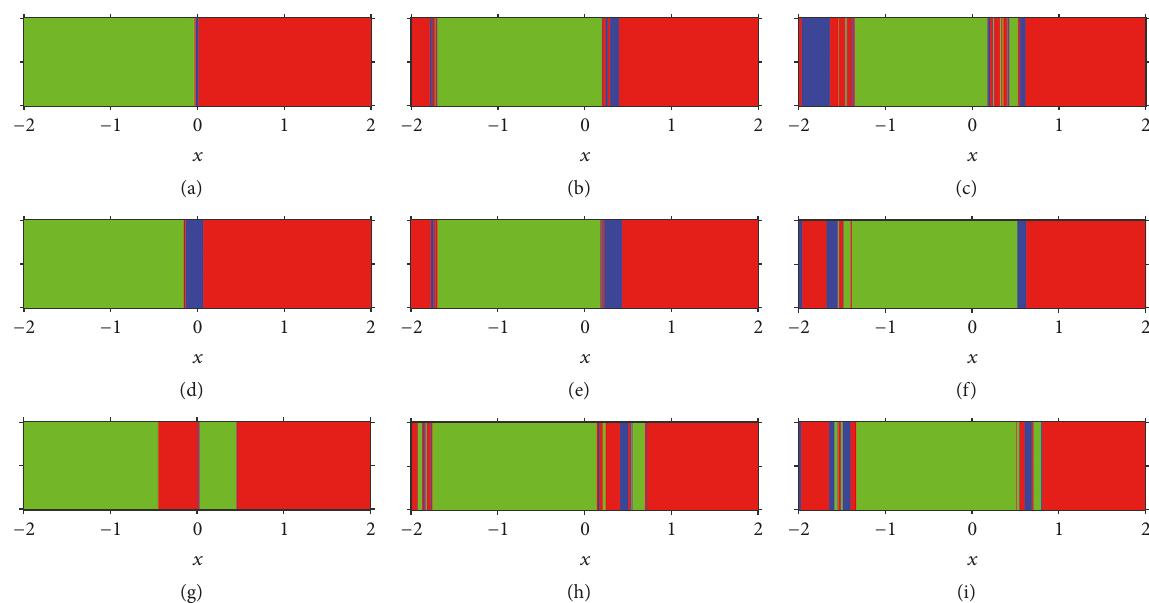
Figure 4: Dynamical lines of methods with (a) (𝛼,𝛾) = (0.5, 0.05) , (b) (𝛼,𝛾) = (0.5, 1) , (c) (𝛼,𝛾) = (0.5, 2) , (d) (𝛼,𝛾) = (1,0.05) , (e) (𝛼,𝛾) = (1, 1) , (f) (𝛼,𝛾) = (1, 2) , (g) (𝛼,𝛾) = (2, 0.05) , (h) (𝛼,𝛾) = (2, 1) , and (i) (𝛼,𝛾) = (2, 2) (red: 𝑥 ∗